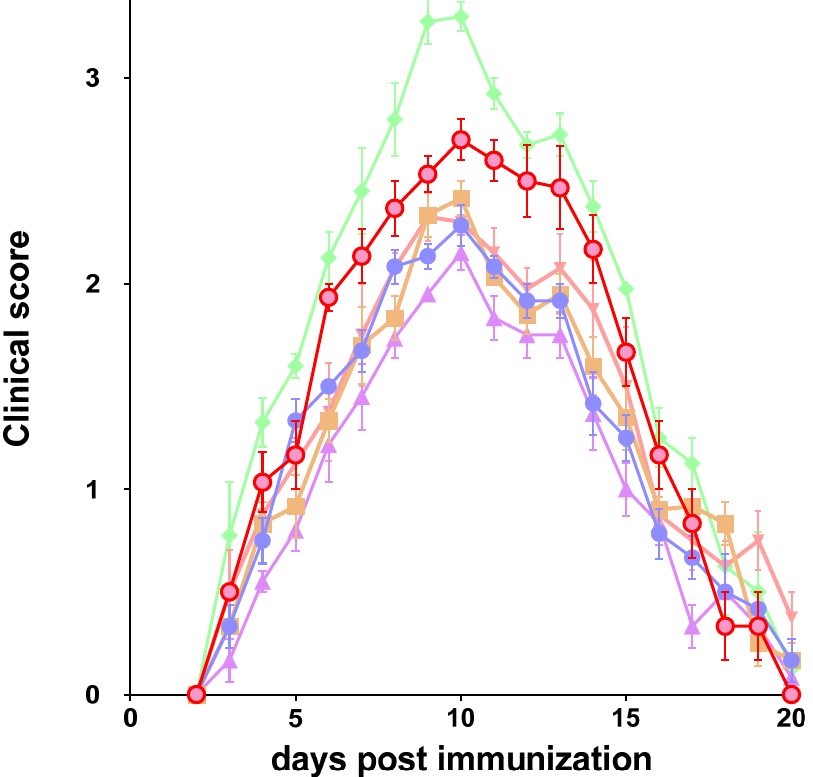
Figure 1. Clinical course of EAE in Sprague-Dawley rats. Rats showed the maximal signs on day 10. Rats were immunized and treated as indicated in Section 4. EAE immunized rats ( ♦ ); EAE immunized rats treated with glatiramer acetate ( ▼ ), interferon beta 1b ( ● ), melatonin ( ▲ ), glatiramer acetate + melatonin ( ■ ), or interferon beta 1b + melatonin ( ● ). Clinical scores are expressed as the mean ± SD.